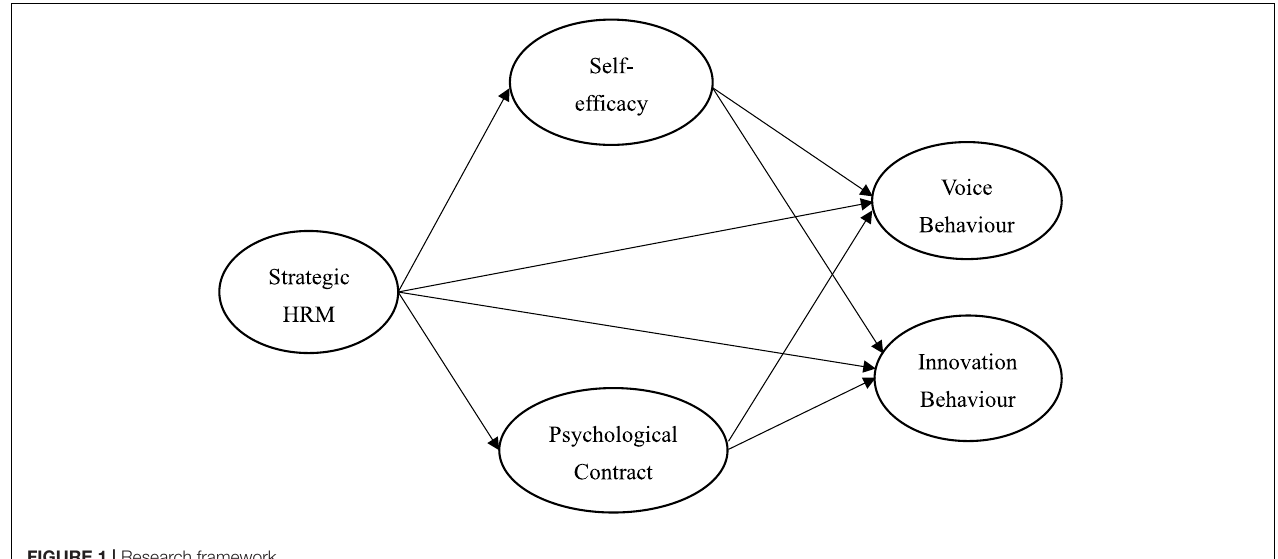
FIGURE 1 | Research